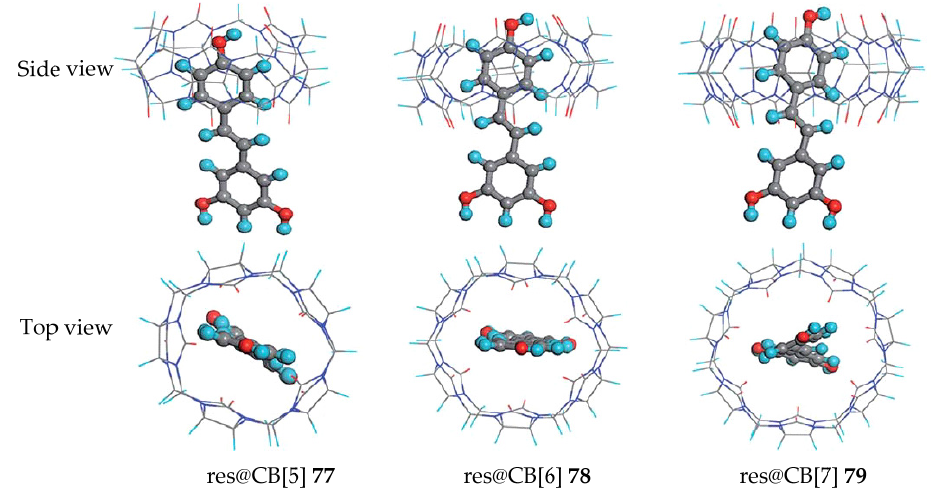
Figure 11. Inclusion complexes of resveratrol in cucurbiturils [87].